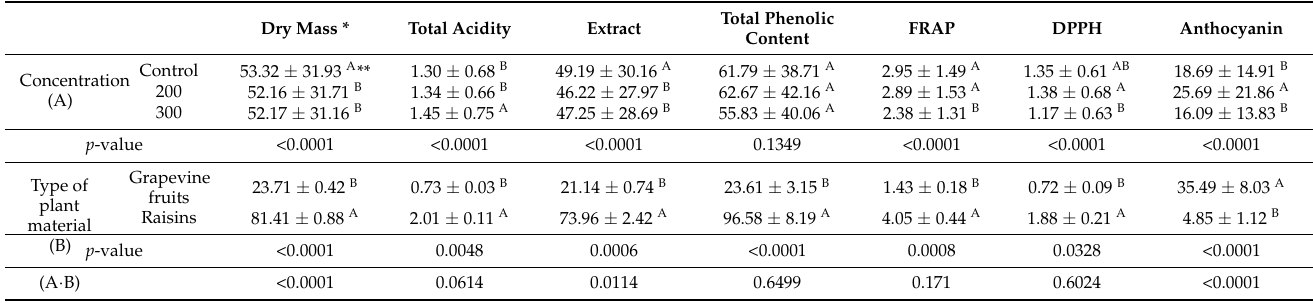
Seedless’ fruits and